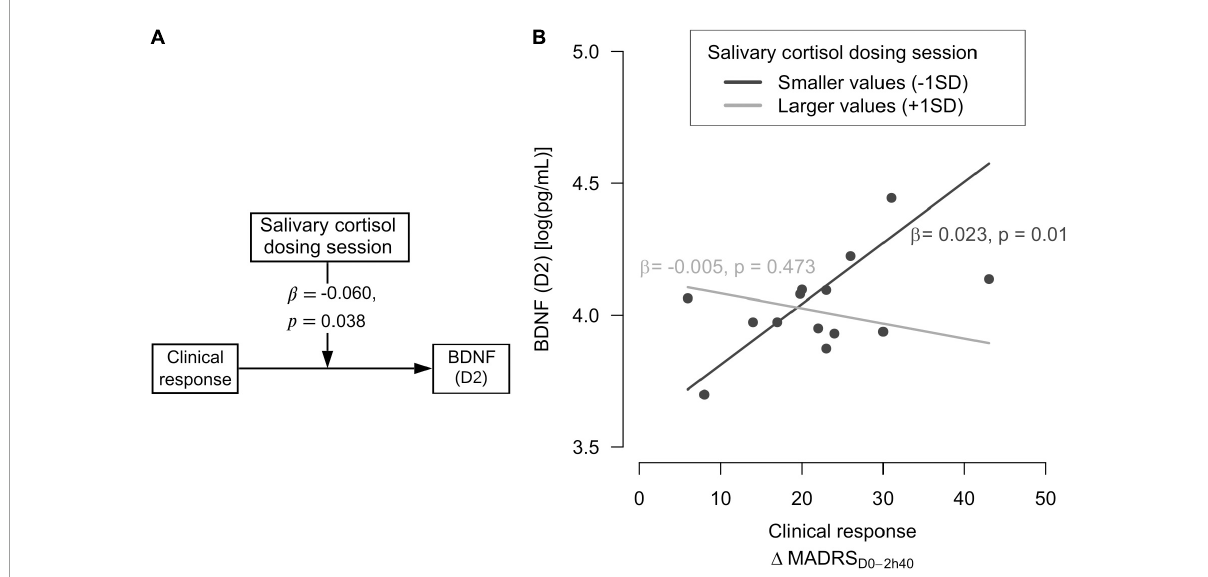
FIGURE3 Moderator of ayahuasca antidepressant action according to patients’ clinical response. (A) The salivary cortisol measured at the dosing session moderated the relationship between clinical response (MADRS D0 -MADRS D2 ) and BDNF levels at D2 (2 days after dosing). (B) Smaller salivary cortisol changes were associated with higher serum Brain-derived Neurotrophic Factor (BDNF) levels in patients with stronger clinical response (reductions in depressive symptoms). Dark gray line means statistically significant interaction ( p ≤ 0 . 05); light gray line means not statistically significant